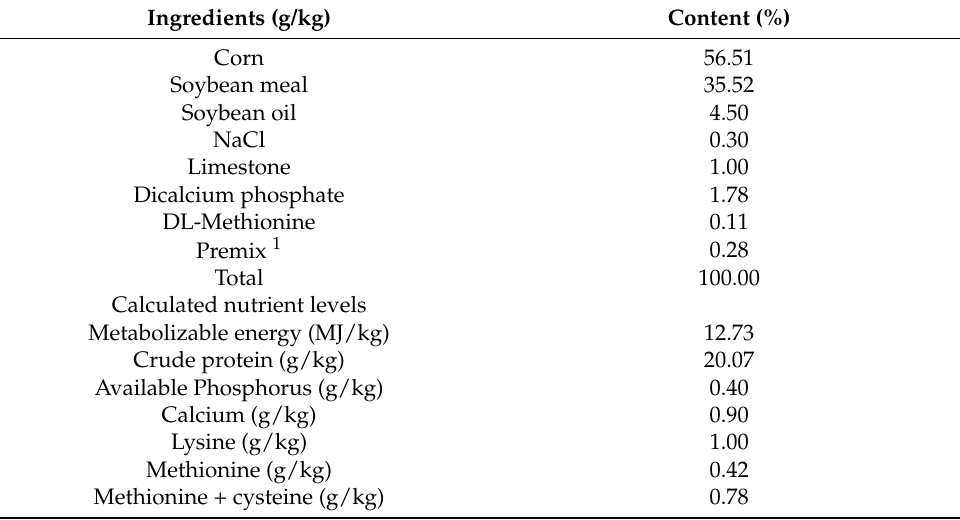
Table 1. Ingredients and nutrient compositions of the basal